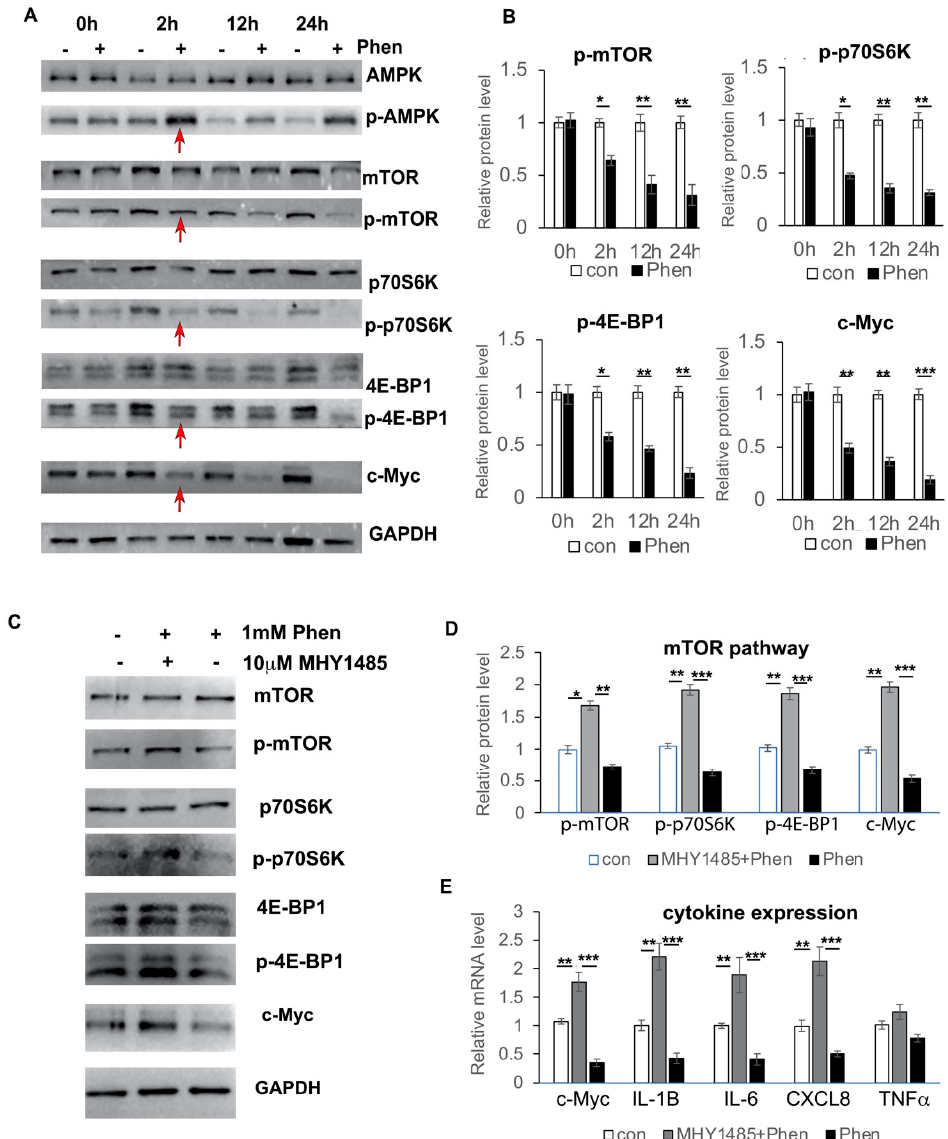
Figure 6. Phenformin controls c-Myc expression through down-regulation of the mTOR pathway in human keratinocytes. ( A , B ) Primary human keratinocytes were treated with 1 mM phenformin (+) or PBS ( − ) and were collected at different time points for Western blot analysis of total and phosphorylated levels of AMPK, mTOR, p70S6K and 4E-BP1 proteins, as well as c-Myc; GAPDH was used as a loading control. Levels of the phosphorylated forms of these proteins relative to the control PBS-treated cells (expression level as 1) are shown in ( B ); densitometry measurements for the phosphorylated forms were normalized to the amounts of total proteins and c-Myc was normalized by GAPDH. Red arrows indicate changes in these protein levels at 2 h. ( C , D ) Primary human keratinocytes were treated with 1 mM phenformin (Phen) with or without 10 µ M mTOR activator MHY 1485 or PBS ( − ) and were collected at 2 h for Western blot analysis of total and phosphorylated levels of mTOR, p70S6K and 4E-BP1 proteins, as well as c-Myc; GAPDH was used as a loading control. Levels of the phosphorylated forms of these proteins relative to the control PBS-treated cells (expression level as 1) are shown in ( D ); densitometry measurements for the phosphorylated forms were normalized to the amounts of total proteins and c-Myc was normalized by GAPDH. ( E ) Primary human keratinocytes were treated with the same conditions as ( C ) and cells were collected at 2 h for RT-PCR analysis of mRNA expression levels of the indicated genes normalized by the human 36 β 4 gene. ( B , D , E ): Student’s t test analysis was used for all quantification data to compare two different concentration groups as indicated, n = 3, standard deviation bars are shown, * p < 0.05; ** p < 0.01; *** p <